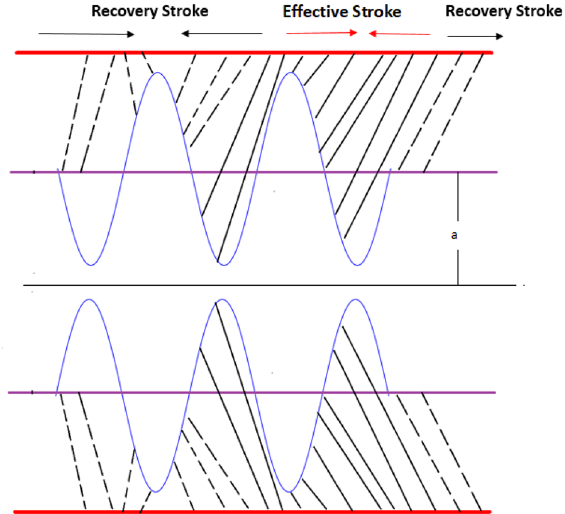
Figure 1. Metachronal wave pattern are exhibited due to ciliary wave